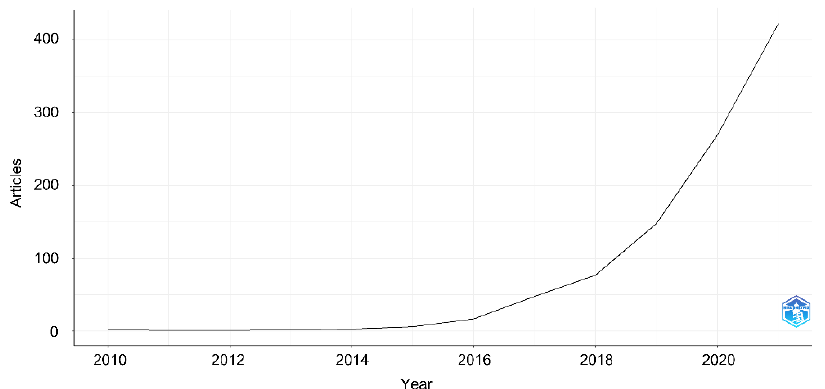
Figure 1. Annual Scientific Production of the publications mentioning the use of FTIR technology to analyse MPs. The plot was generated using the open-source tool Biblioshiny for Bibliometrix [38].